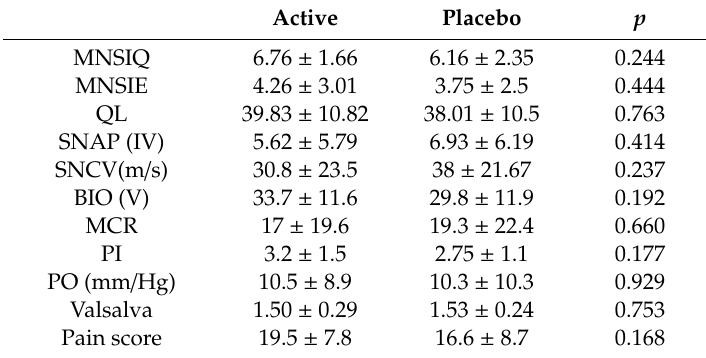
Table 3. Indices of Cardiovascular Autonomic Reflex Tests (CARTs) and neuropathy test at